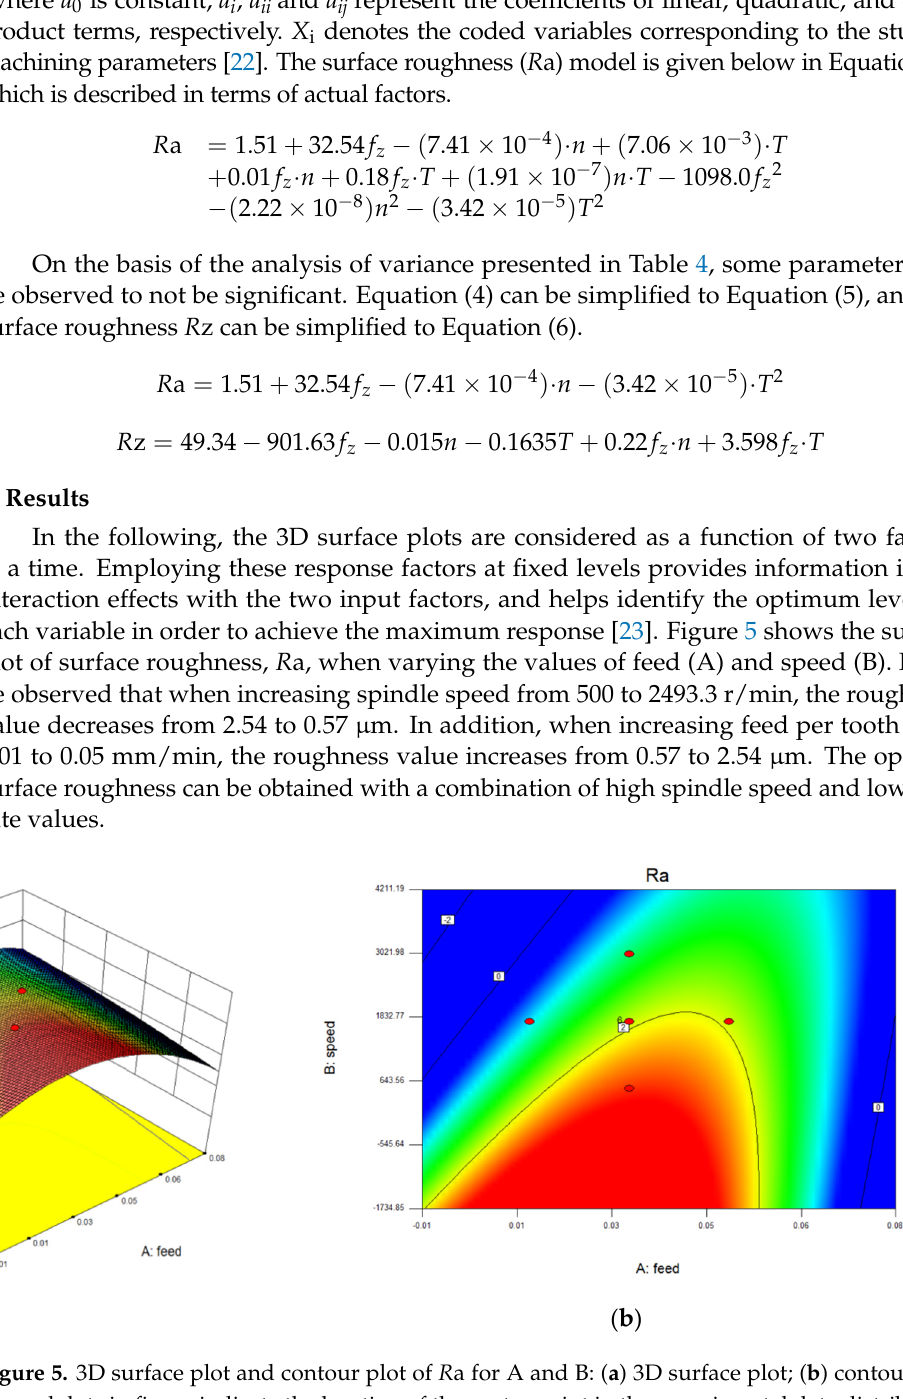
( b ) Figure 6. 3D surface plot and contour plot of R a for A and C: ( a ) 3D surface plot; ( b ) contour plot. Figure 7 shows the surface plot of surface roughness, R a, when varying the values of speed (B) and temperature (C). It can be observed that when increasing the spindle speed from 1898.7 to 2493.3 r/min, the roughness value decreases from 1.4 to 1.8 μ m. The surface roughness first increases and then decreases. With increasing spindle speed from 1006.8 to 1898.7 r/min, the roughness value increases from 1.8 to 2.2 μ m. When the spindle speed is low, the roughness changes slowly with temperature, on the basis of the contour plot.